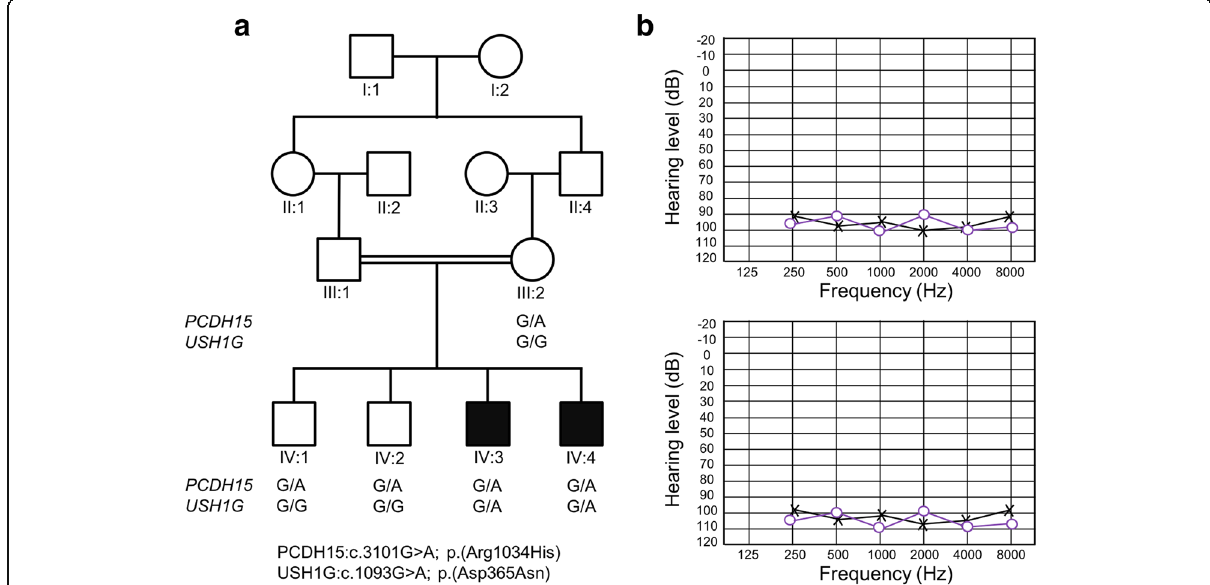
Fig. 1 Pedigree drawing for family 4667 and audiograms for the affected family members. Panel a Pedigree drawing displaying family members with NSHI as filled symbols and unaffected family members as clear symbols. Males are represented by squares and females by circles. For the three unaffected and two affected family members genotypes for the PCDH15 variant NM_033056:c.3101G>A and USH1G variant NM_173477:c.1093G>A are shown under each family member and demonstrate digenic inheritance. The DNA sample from Individual IV:4 was exome sequenced. Panel b Audiograms for affected family members IV:3 (top) and IV:4 (bottom). Pure-tone audiometry was performed between 250 and 8000 Hz and x represents the results for the left ear and o for the right ear. Affected individual IV:3 was 34 years old, and affected individual IV:4 was 22 years old at the time of pure-tone audiometry and physical